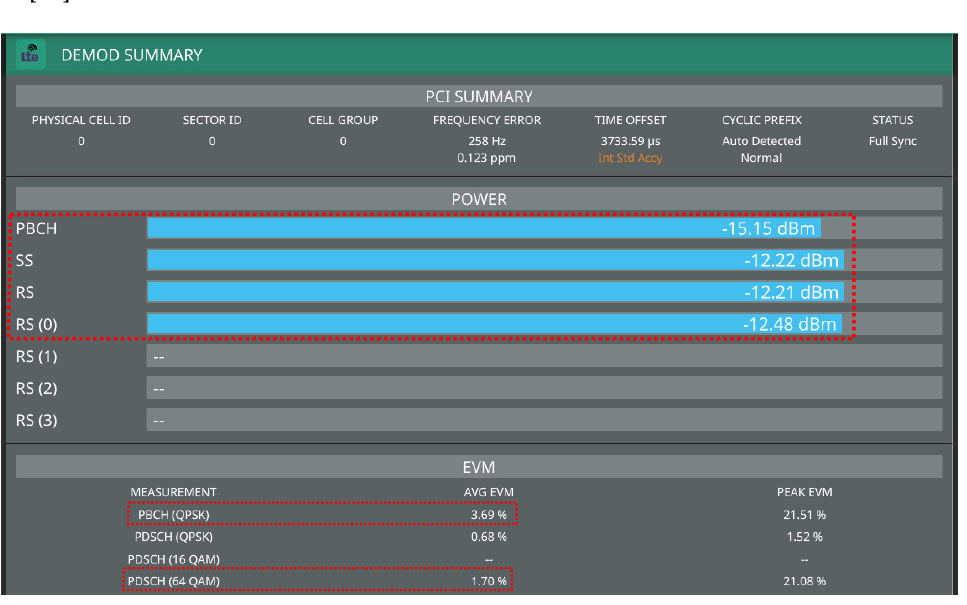
Figure 7. Transmitted Signal Demodulation from